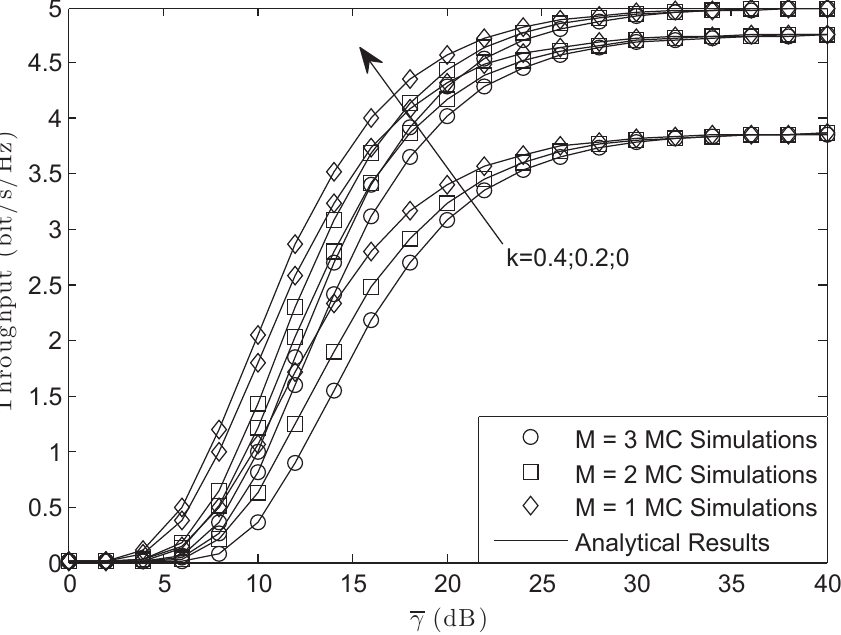
Figure 9. Throughput of the system versus different γ with σ = 0.8, L = 10 and γ 0 = 3 dB: